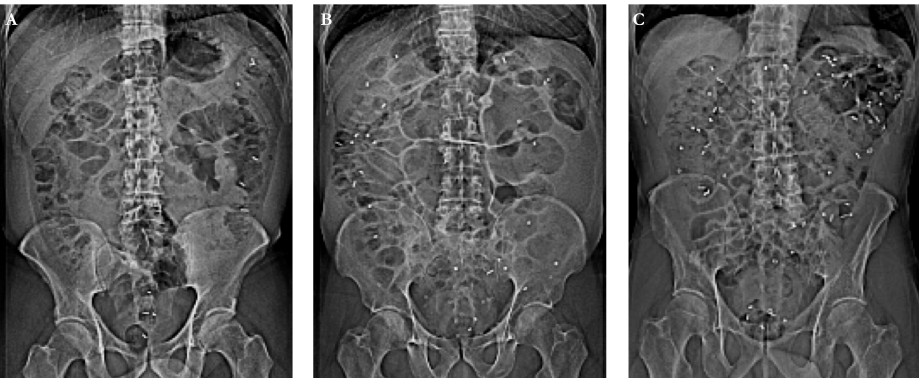
Figure 2. Abdominal x-ray topograms visualizing the retention of radio-opaque markers in the gastrointestinal tract as an objective measure of colonic transit time (CTT). ( A ). Healthy control with an estimated CTT within the normal range. ( B ). Parkinson’s disease (PD) patient with an estimated CTT near the mean for PD patients. ( C ). PD patient with severely prolonged CTT.